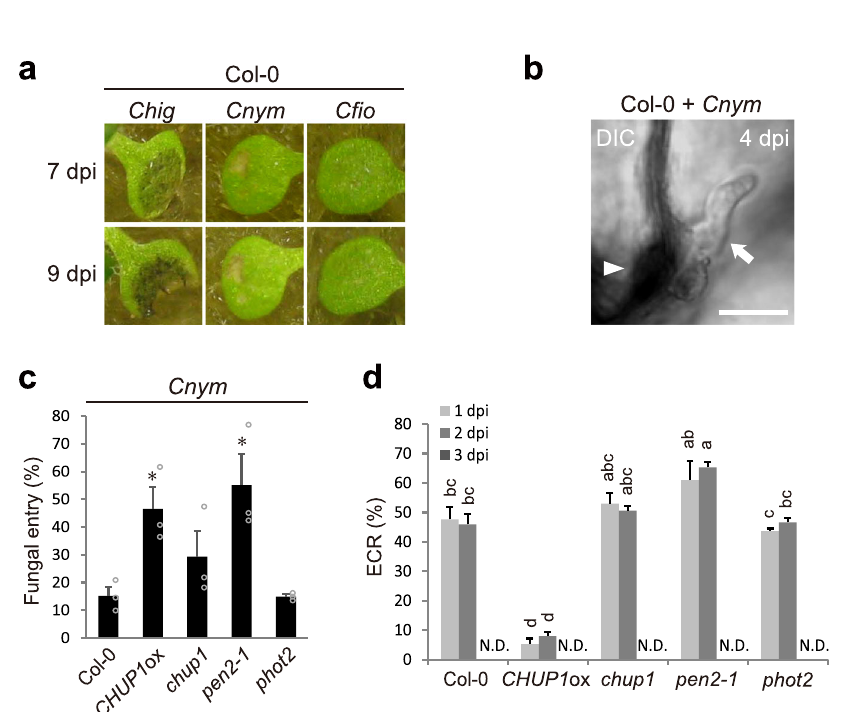
Fig. 8 The ECR strongly occurs and contributes to NHR against speci fi c nonadapted Colletotrichum fungus in wild-type Arabidopsis . a Pathogenicity of Colletotrichum fungi on wild-type Arabidopsis (Col-0). A conidial suspension of adapted Chig and nonadapted Cnym and C fi o was inoculated onto cotyledons of Col-0 and incubated for 7 and 9 days. b , c Cnym invasion into epidermis of Col-0 at 4 dpi. The arrowhead and arrow indicate melanized appressorium and invasive hypha, respectively. Scale bar, 10 µ m. For quanti fi cation of fungal entry of Cnym , 300 melanized appressoria were investigated at 4 dpi. d Quanti fi cation of ECR in Col-0, CHUP1 ox, chup1 , pen2-1 , and phot2 plants after inoculation of Cnym at 1, 2, and 3 dpi. A total of 100 cells in contact with the melanized appressorium were observed. For all quanti fi cation analyses, the means and SE were calculated from three independent plants. Means not sharing the same letter are signi fi cantly different ( P < 0.05, two-way ANOVA with Tukey ’ s HSD test). The asterisks indicate signi fi cant difference (* P < 0.05, one-way ANOVA with Dunnett ’ s